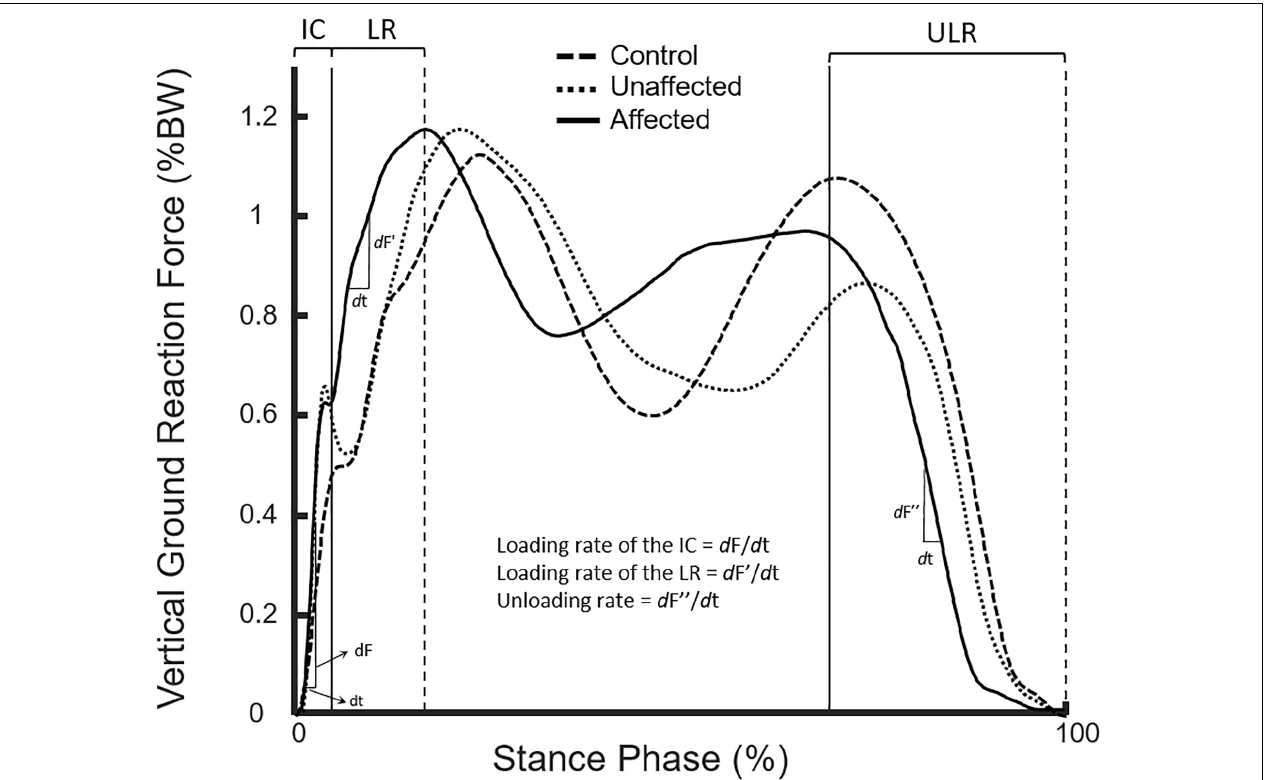
FIGURE 2 | Curves of body-weight-normalized vertical ground reaction forces of the affected (solid line) and unaffected (dotted line) limbs of typical subjects in the DDH and Control group (dash line) during the stance phase of level